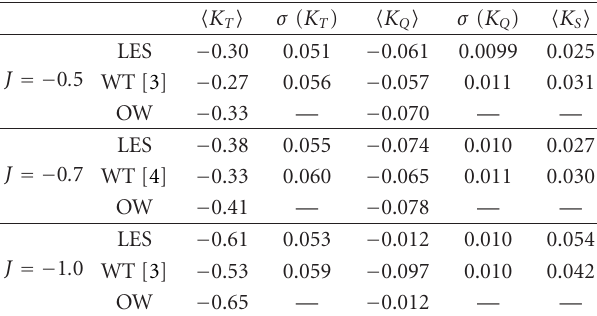
Table 1: Statistics of unsteady loads for open propulsor at three advance